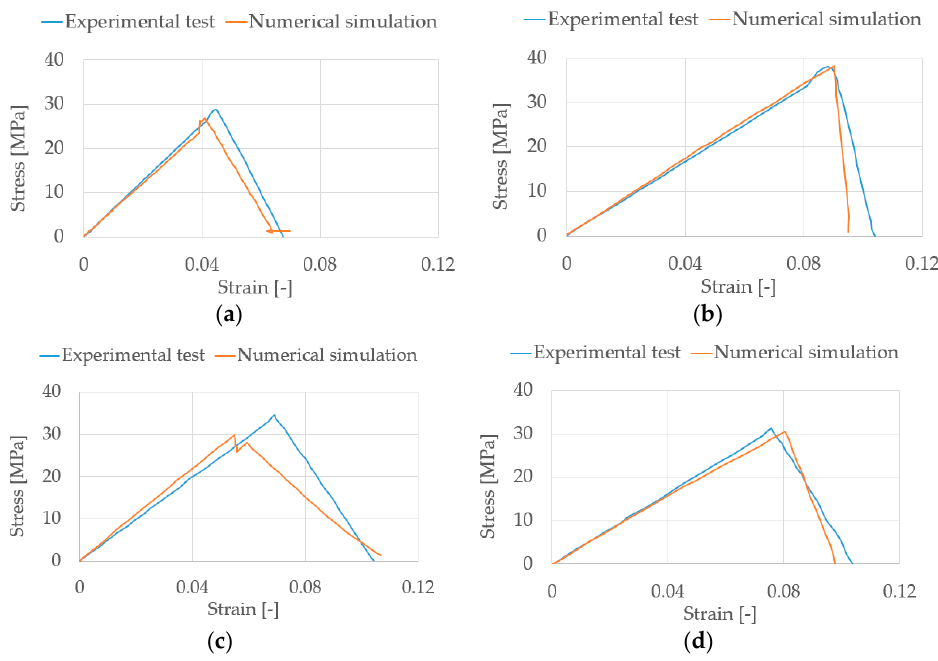
Figure 12. Stress vs. strain in the composite material: ( a ) PoH15; ( b ) PoH20; ( c ) PoB5H15; ( d ) PoB5H25. ( d )